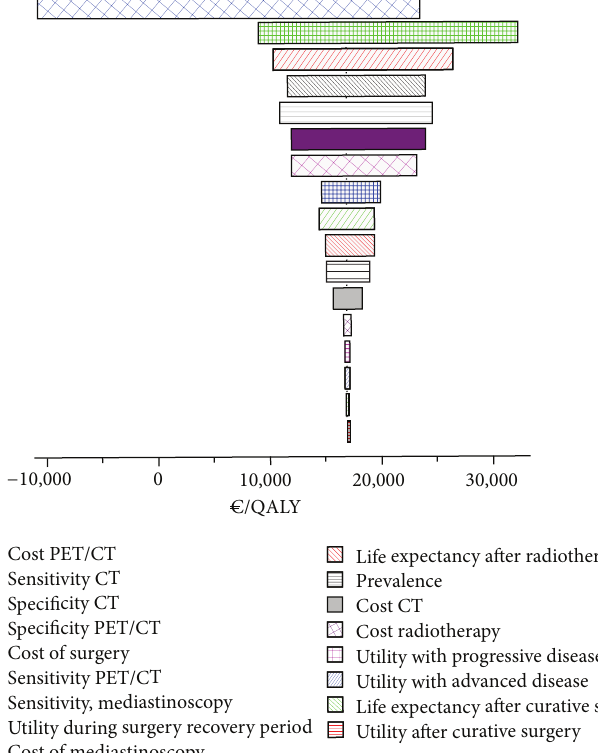
Figure 4: Tornado chart showing the variation in cost-effectiveness of PET/TC and CT depending on the variables included in the decision tree.